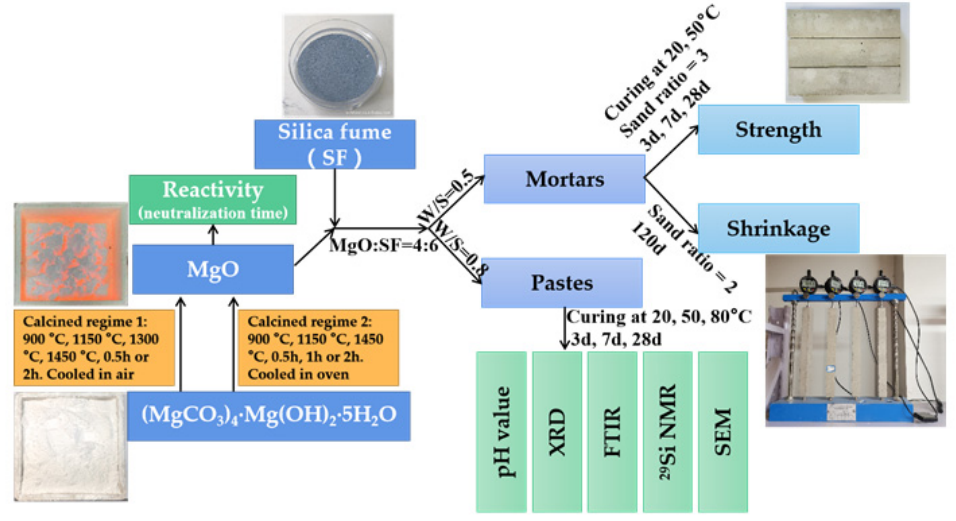
Figure 1. Methodology flowchart of the current study.